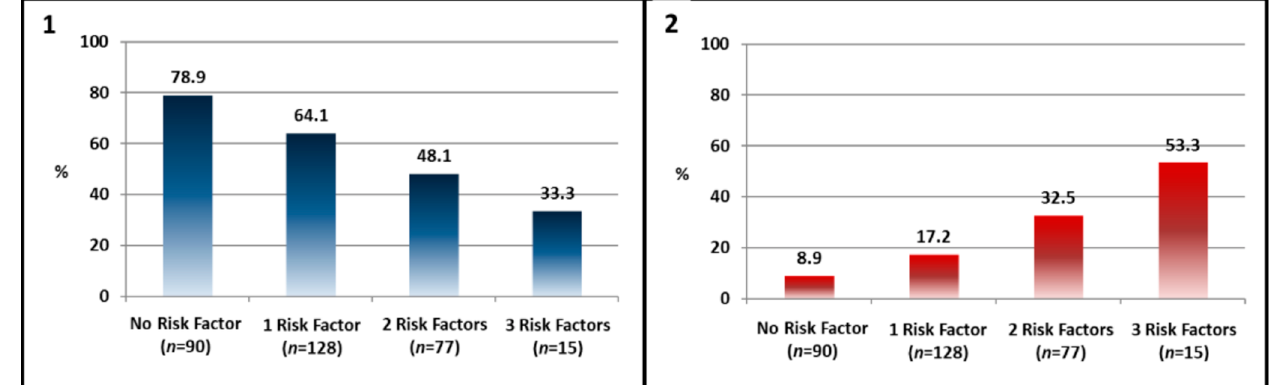
Figure 2. Predictors of death at 1 year in the elderly group. ( 1 ) All cause death in patients above and below 80 years old; ( 2 ) All cause death in patients with and without COPD; ( 3 ) All cause death in patients with and without CKD; ( 4 ) All cause death in patients with 1-2-3 or none of the abovementioned risk factors.The Kaplan – Meier curves show the reduction in survival in patients aged > 80 years (left upper panel), in patients with COPD (right upper panel) and in patients with CKD (left lower panel). Patients with all three factors have the lowest survival (right lower panel). COPD: chronic obstructive pulmonary disease; CKD: chronic kidney disease.